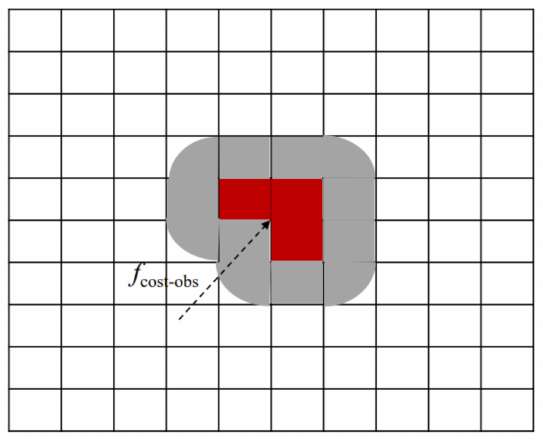
Figure 4. Obstacle expansion